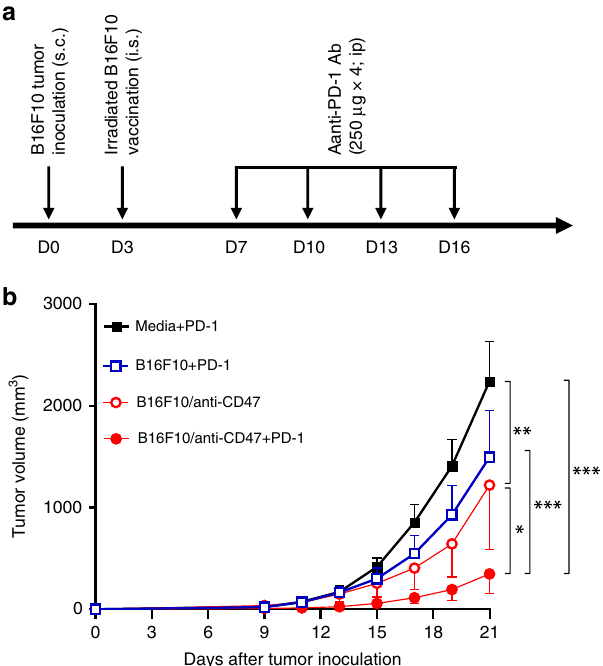
Fig. 8 Synergistic antitumor effect of anti-CD47-coated tumor cells and anti-PD-1 Ab. a Schematic outline of the experimental design. b Tumor growth in B16F10 tumor-bearing mice that received media plus anti-PD-1 ( n = 5), vaccination with irradiated B16F10 plus anti-PD-1 ( n = 8), with irradiated/anti-CD47 Ab-coated B16F10 ( n = 7), or with irradiated/anti- CD47 Ab-coated B16F10 plus anti-PD-1 ( n = 8). Tumor growth is shown as tumor volumes (mean ± SEM) over time. * p < 0.05; ** p < 0.01; *** p < 0.001 (two-way ANOVA). Source data are provided as a Source Data fi